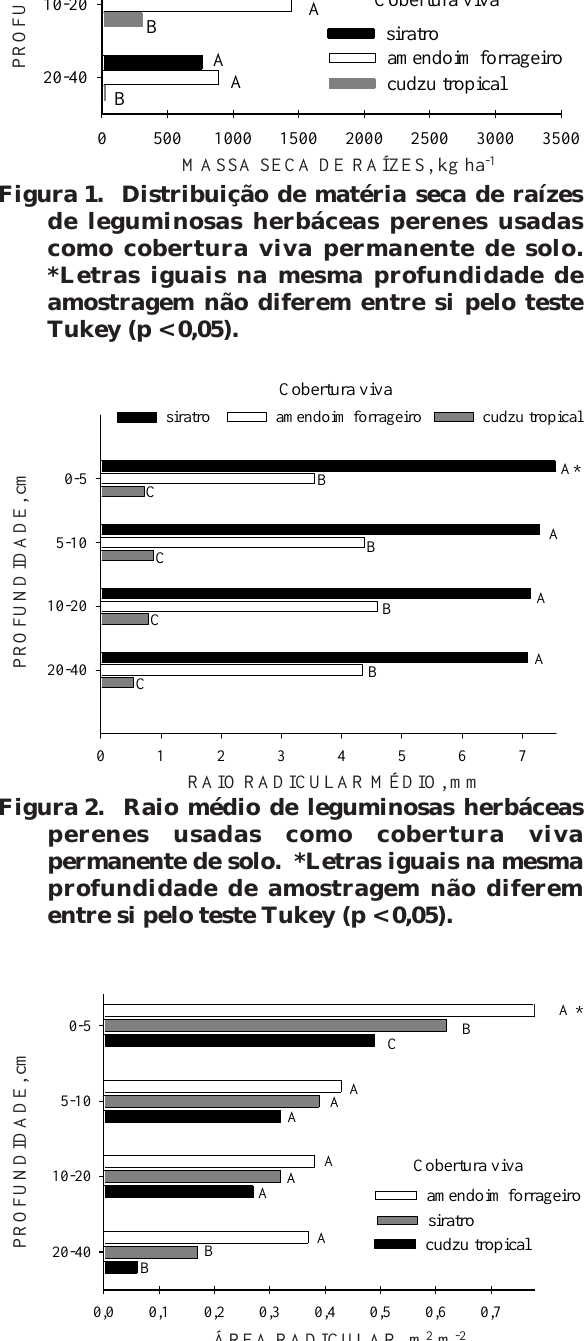
Figura 3. Área radicular de leguminosas